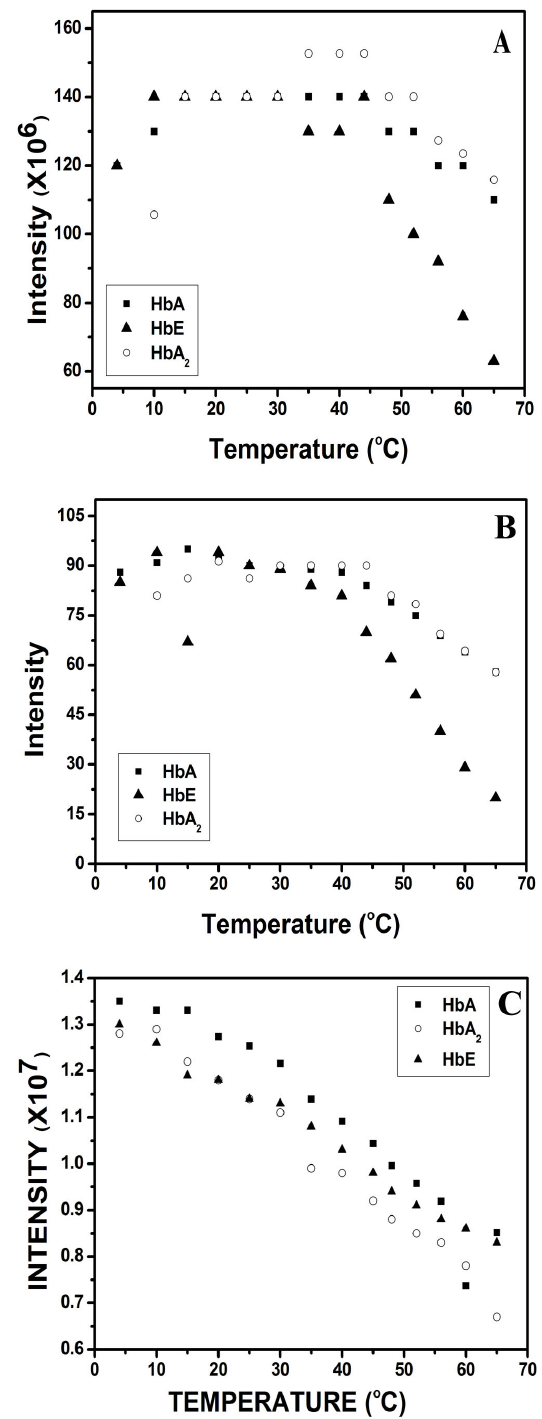
Figure 3. Change in fluorescence intensity in the HbA, HbA and HbE (5.0 µM) as a function of temperature at pH 4.0. The 2 changes are reflected by ( A ) synchronous fluorescence for tryptophan emission, ( B ) synchronous fluorescence for tyrosine and ( C ) Change in synchronous fluorescence for tryptophan of HbA, HbA and HbE (1.0 µM) as a function of temperature at pH 2.5. Sharp 2 decrease in intensity values in (A) and (B) indicate formation of unstable and insoluble aggregates which starts at a much lower temperature for HbE than HbA & HbA while at pH 2.5 all the variants become much more temperature sensitive as they are 2 completely unfolded. doi: 10.1371/journal.pone.0081820.g003 PLOS ONE |